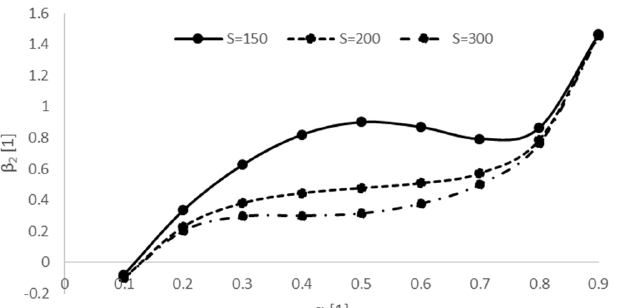
Figure 4: The values of normalized stress intensity factor B 2 for three cases of homogeneous concrete specimens of lengths S =150, 200, 300 mm